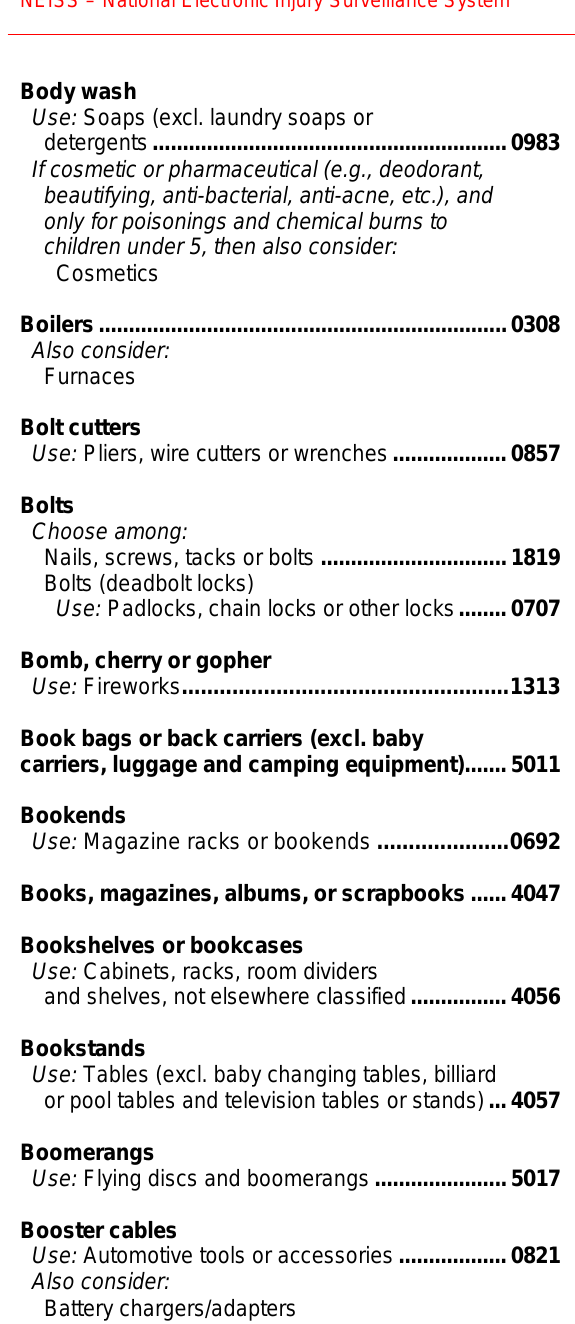
Battery chargers/adapters